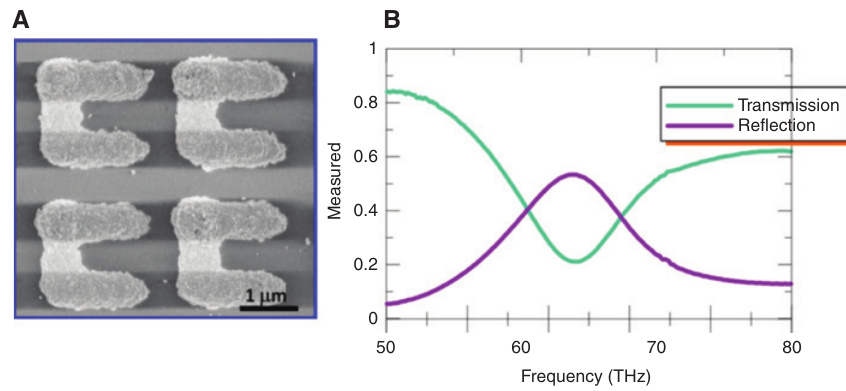
Figure 3: Direct laser written THz-metamaterials. (A) Scanning electron microscopy (SEM) image of a split-ring resonator array made of gold with a scan speed of 2 μ m/s and a laser power of 1.57 mW. (B) Corresponding measured terahertz response of the resonator array showing the feasibility of the photoreduction technique for the fabrication of nanophotonic structures. Reprinted with permission from Ref. [86]. Copyright 2013, Optics Materials